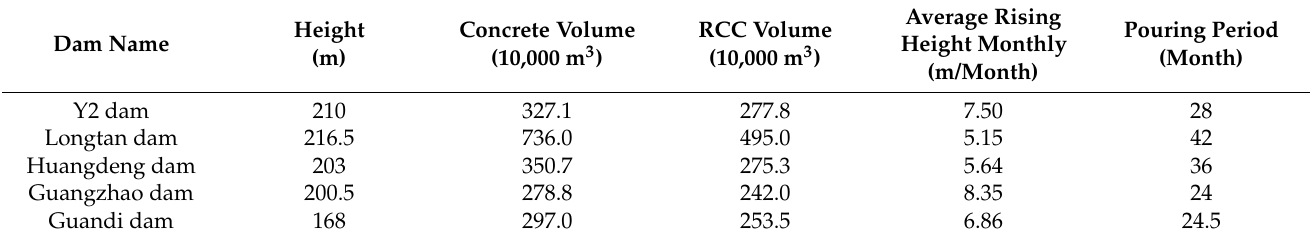
Table 13. The key construction parameters of RCC gravity dams in